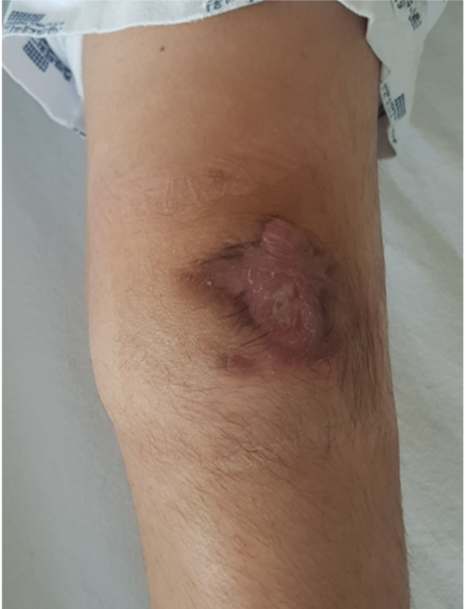
Figure 4. One year and six months after the onset of symptoms, gross examination of the knee revealed mild swelling on the left knee along with a slightly improved skin lesion and persistent discharge.